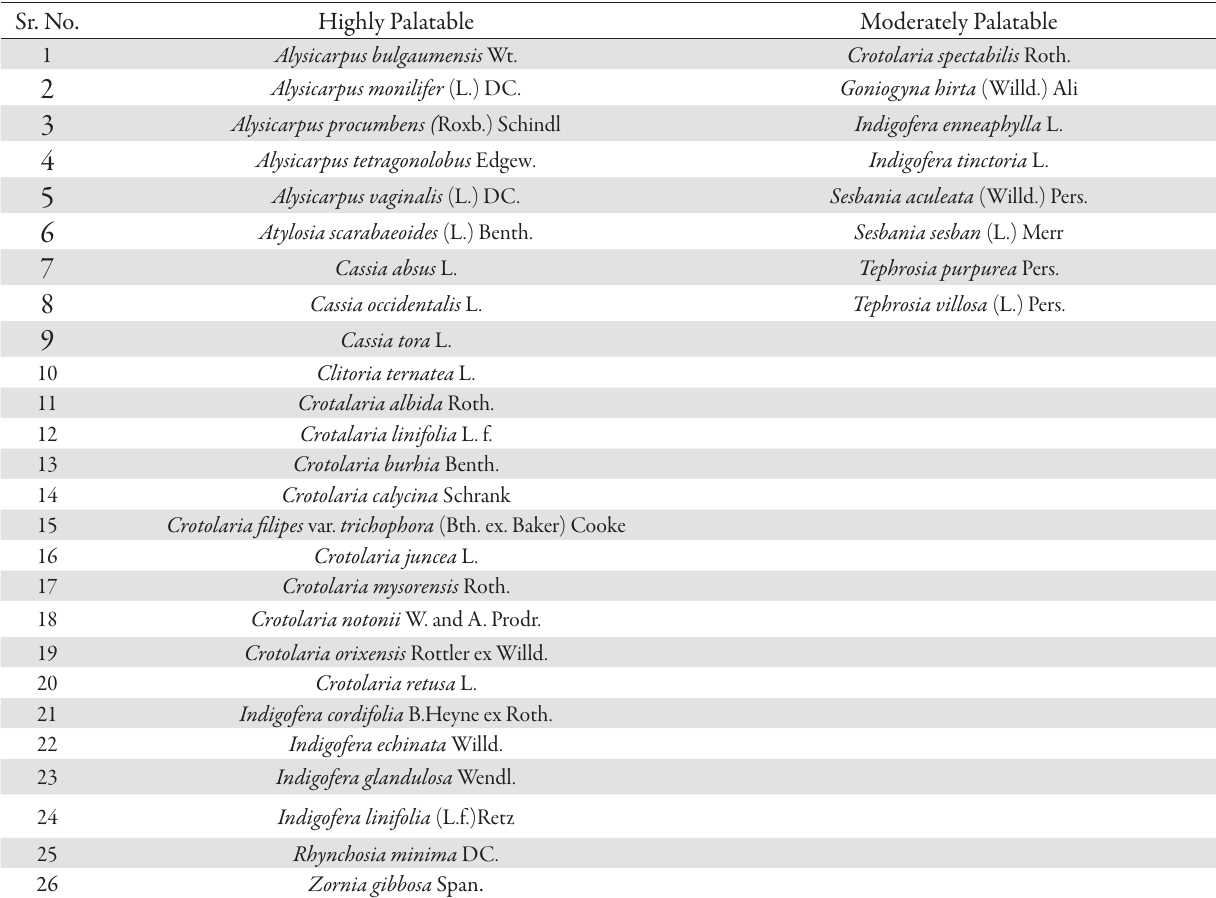
Tab. 3. List of Palatable Legumes Sr.